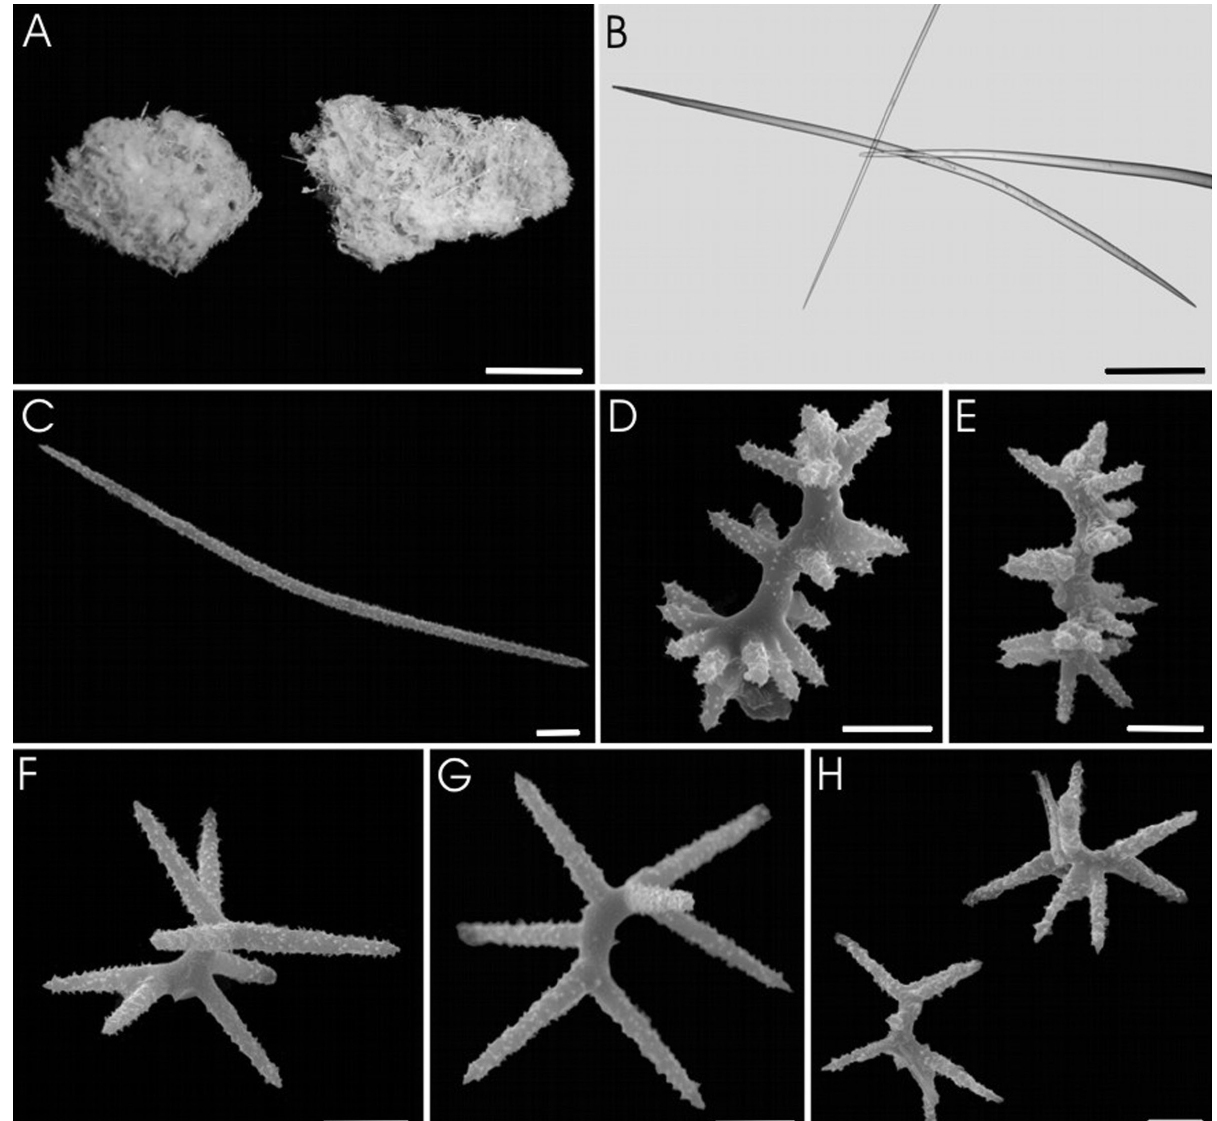
Fig . 4. – Poecillastra sinetridens n. sp. A, schizotype (MNRJ 9392). B, Oxeas. C, Acanthomicroxea. D-E, Spirasters. F-H, Plesiasters (F, H, metasters). Scale: A, 1 cm; B, 500 µm; C-H, 5